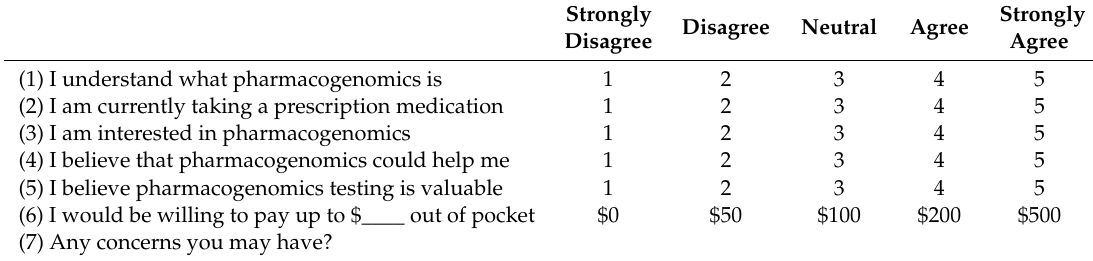
Table 1. Survey questions regarding